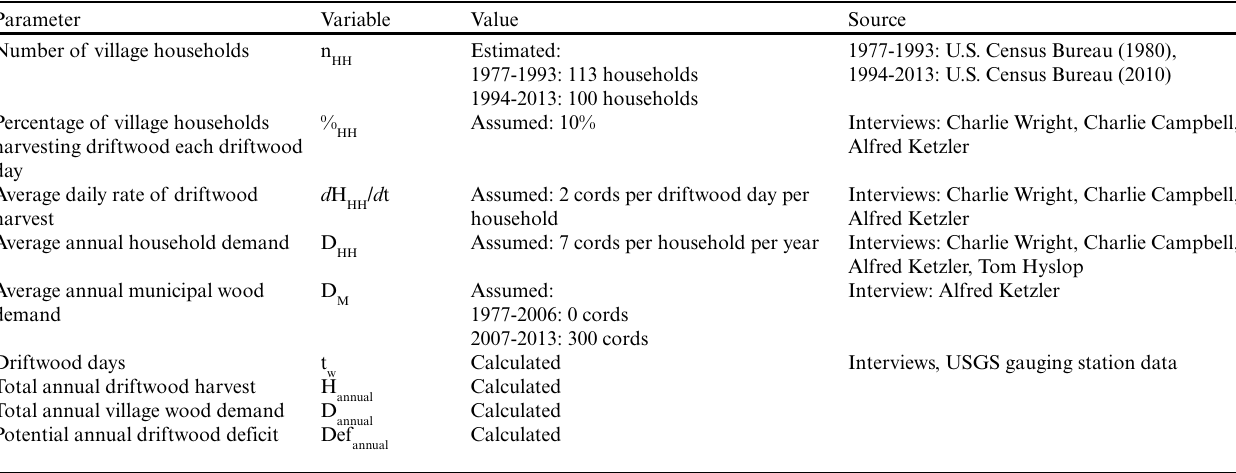
Table 2 . Parameters used in the driftwood harvest model.